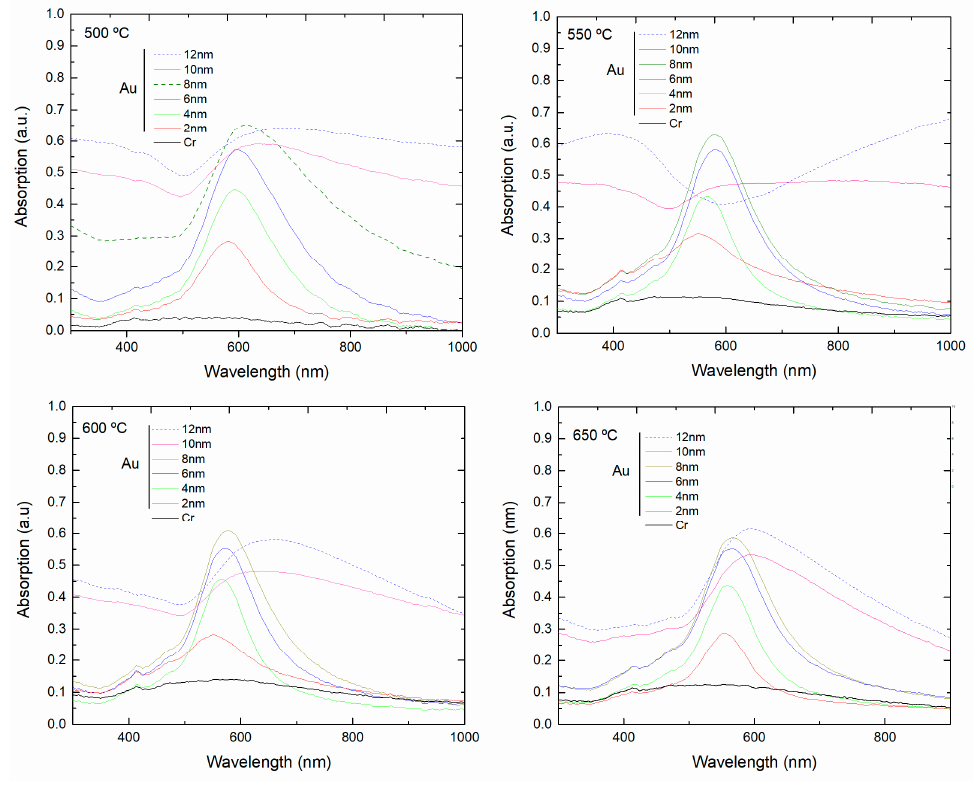
Figure 7. Absorption spectra after annealing at 500, 550, 600 and 650 °C for 1 h of planar samples with 2, 4, 6, 8, 10 and 12 nm gold thin film deposited on substrates with 2 nm of chromium (adhesion layer) and of a sample with 2 nm chromium thin film.